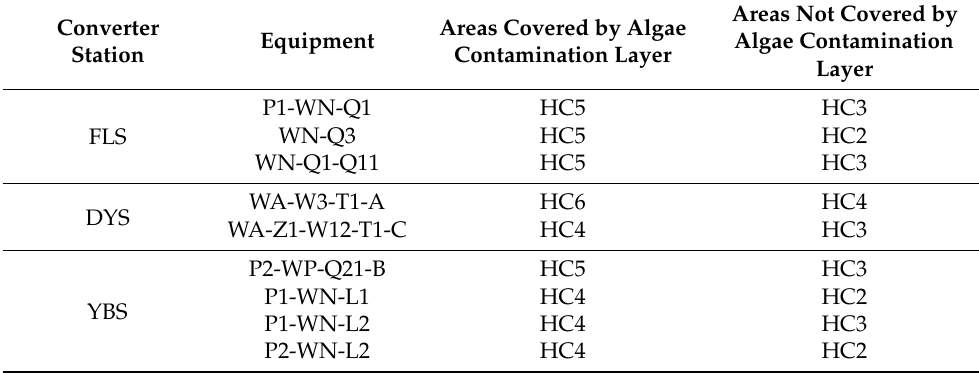
Table 11. The hydrophobicity test results of the RTV coating of the converter station.